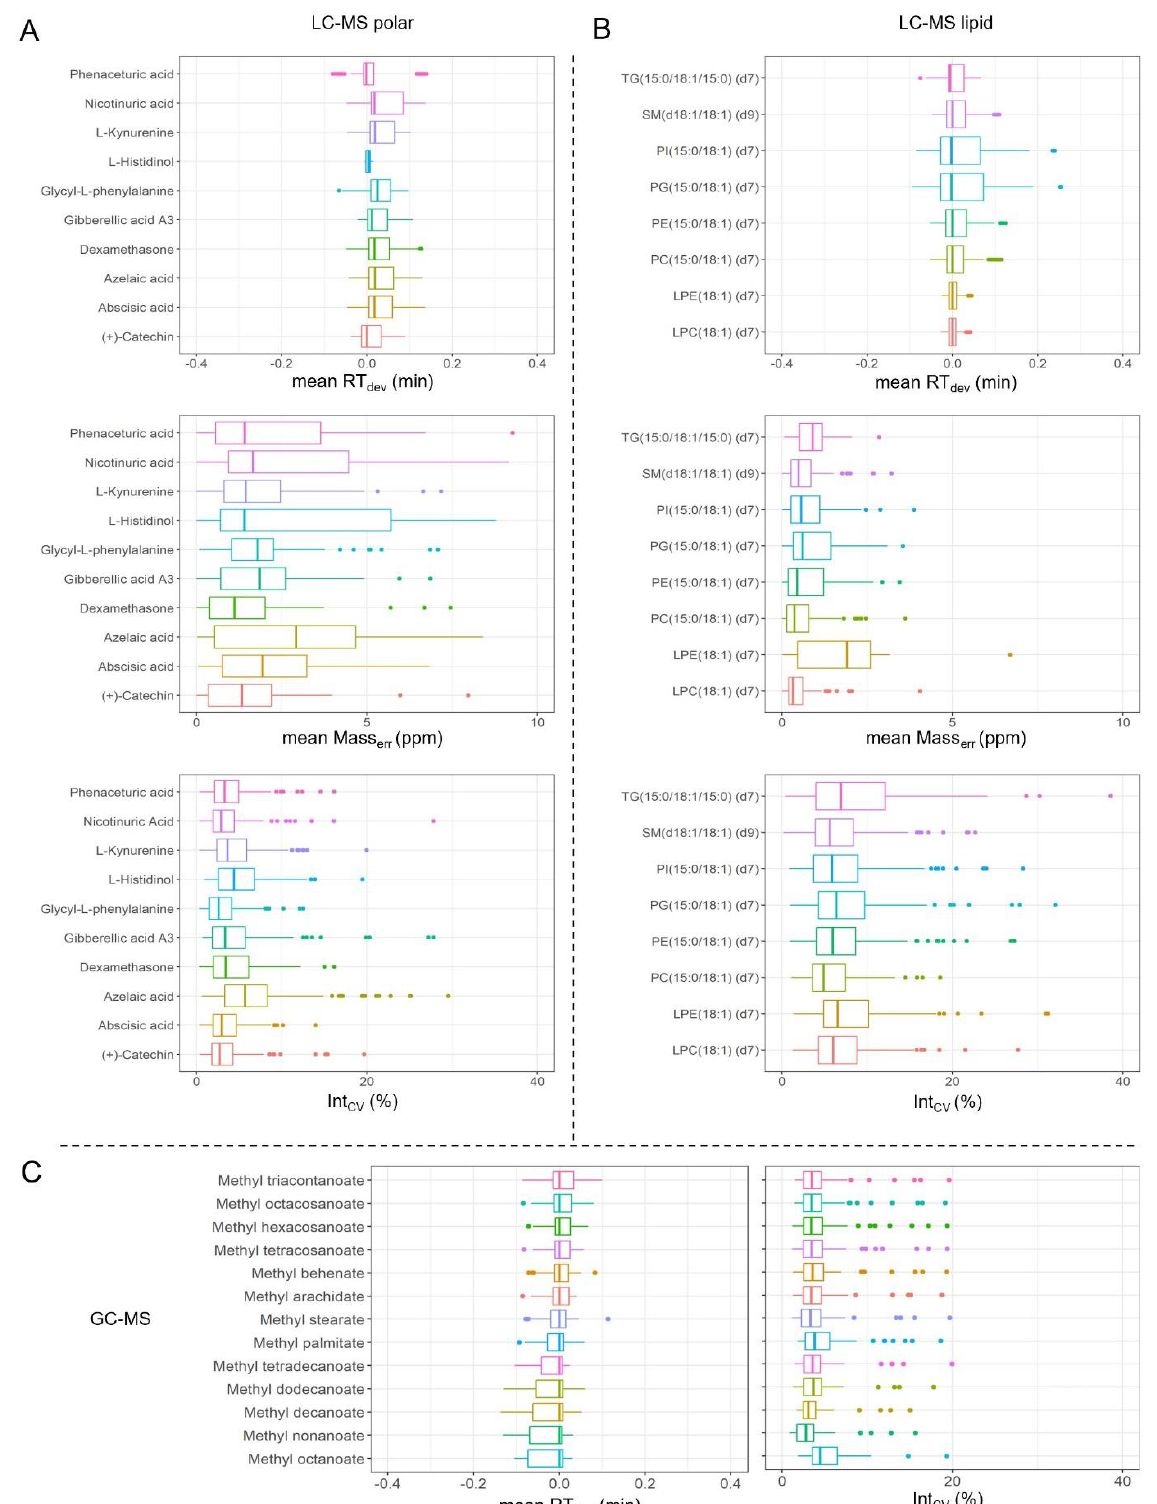
Figure 4. The performance of MS-based platforms across the whole study was visualized using box plots of variable parameters observed from reference compounds. ( A ) LC-MS polar platform. ( B ) LC-MS lipid platform. ( C ) GC-MS platform. RTdev: delta retention time (RT), Masserr: mass error, IntCV: intensity coefficient variation. Each standard value was calculated from 70 batches.